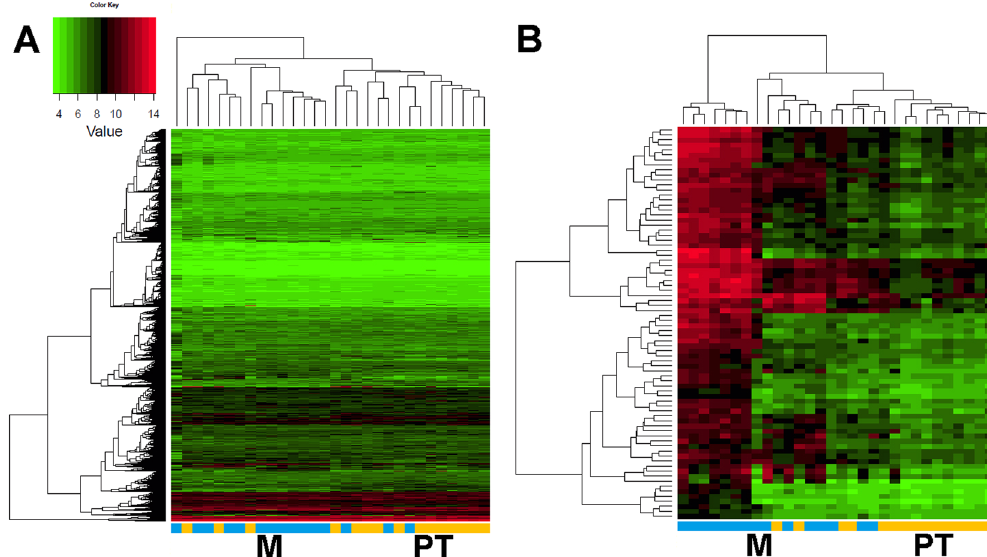
Figure 2. Gene set cluster analysis of 15 lymph node metastasis and their 15 corresponding primary tumours allows profiling of disease progression by identifying a condensed list of 62 most significant genes. Supervised two-way hierarchical clustering and gene tree representation adjusted to the primary site of all genes (A) and differentially regulated genes (B) allow distinguishing lymph node metastasis and primary tumours. X-axis’ represent patient samples; y-axis’ represent the list of probe sets grouped by similarity using Pearson correlation. Intensities recorded for genes are colour coded: Green – low expression, Red – high expression, Black – medium expression. Orange bar: primary tumour samples; blue bar: lymph node metastasis samples. ( A ) Heatmap of all probesets shows the comparison of lymph node metastasis to primary tumours (M vs .PT). ( B ) Stringent filter criteria (log 2 FC ≥ 1.5 and p-value < 0.0001, corresponding to a FDR of 0.004) were used to reduce the probesets for M vs .PT, leading to a condensed list of 62 genes most significantly changed in primary tumours to their corresponding lymph node metastasis. Signature genes are listed separately in Table